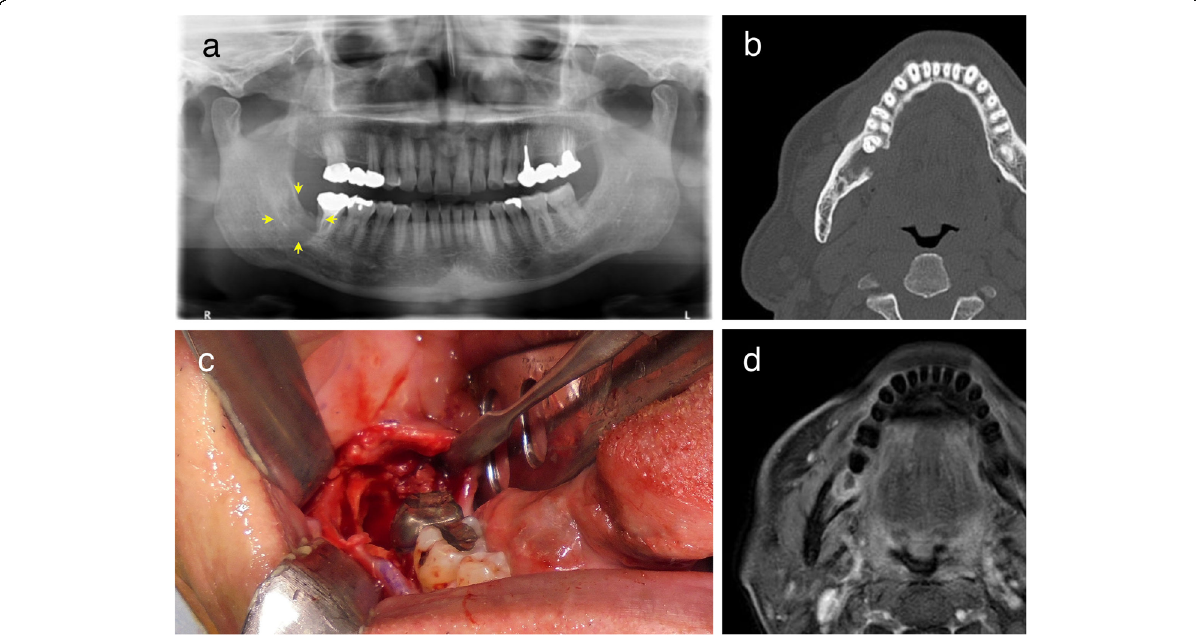
Fig. 1 Radiological findings of the central mucoepidermoid carcinoma (MEC) arising from a glandular odontogenic cyst (GOC) of the mandible. a Panoramic radiograph showing a radiolucent cystic lesion (yellow arrows) in the right third molar region of the mandible. b CT showing a unilocular radiolucent lesion with a lingual side cortical bone resorption of the mandible. c Oral photography showing a cystic cavity in the same area after surgery. d MRI showing a contrast defect in the same area after the biopsy was